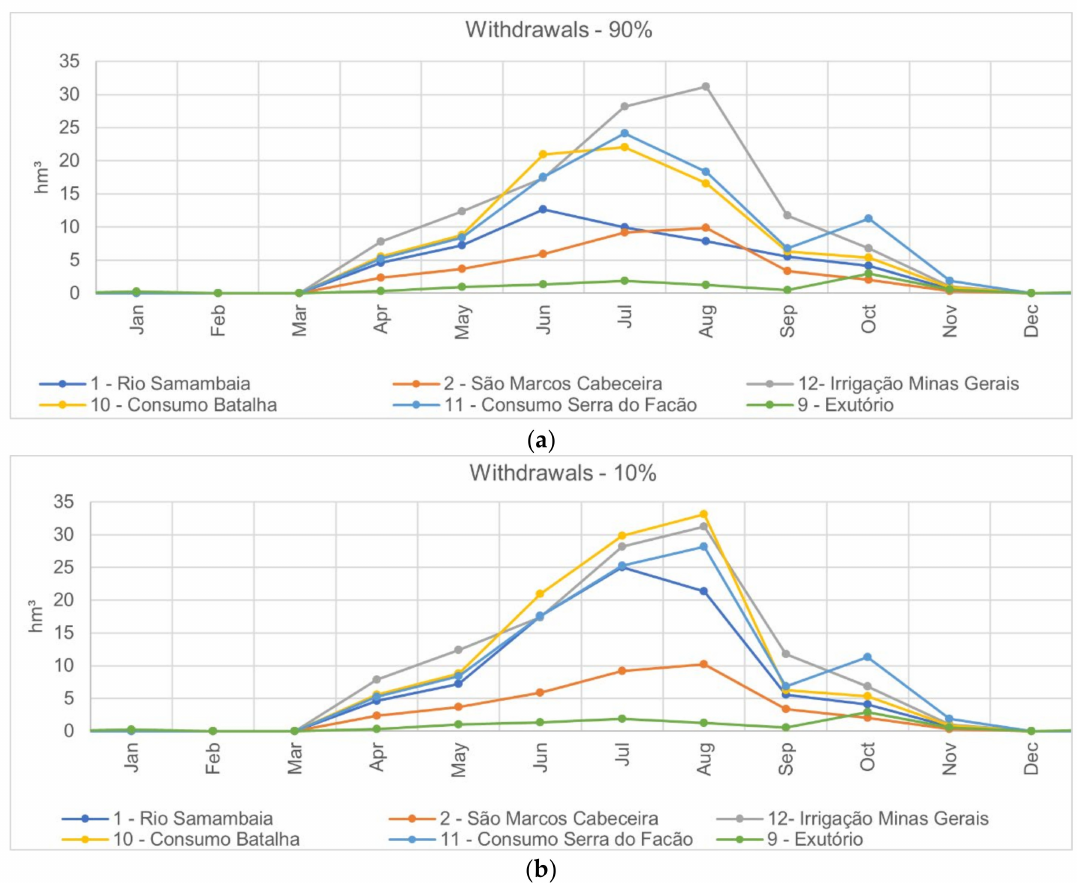
Figure 5. Water withdrawals to irrigated agriculture in the economic arrangement, with 90% ( a ) and 10% ( b ) exceedance